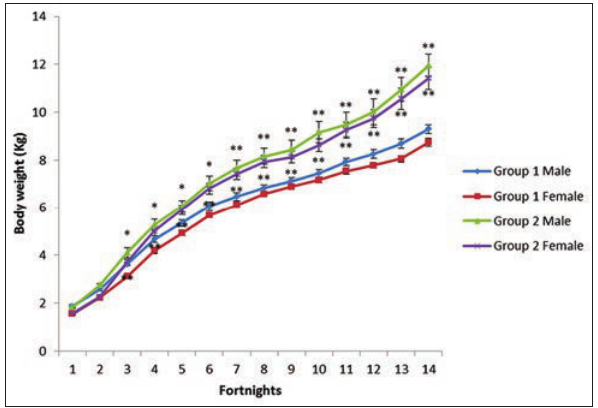
Figure-3: Mean±standard error values of body weight of lambs at fortnight intervals of different groups. *Significantly different from the base value (p<0.05). **Significantly different from the base value (p<0.01).